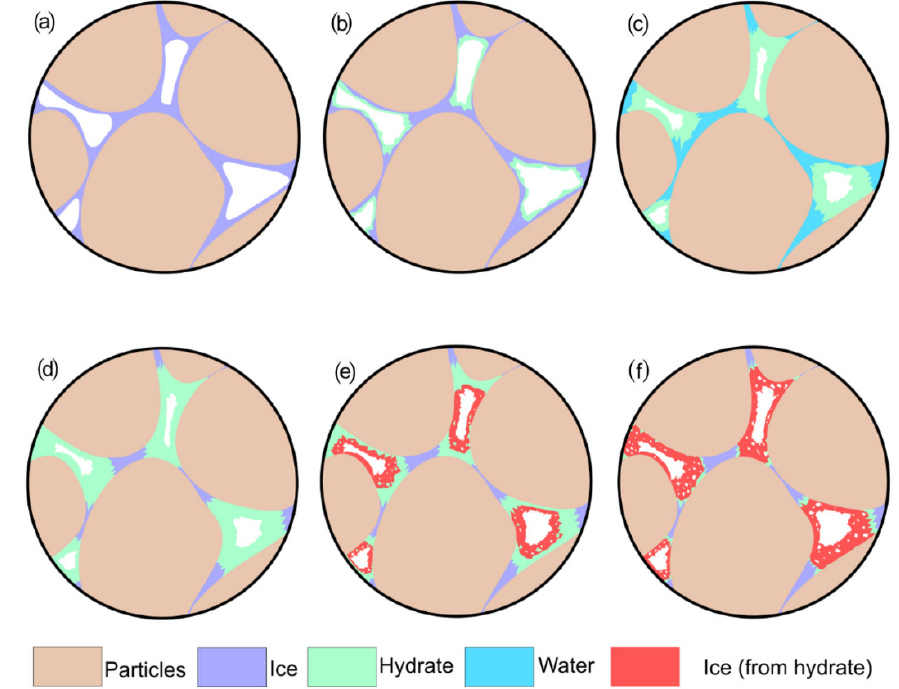
Figure 9. Pore space changes in gas-saturated sediments exposed to hydrate formation at t < 0 °C, thawing and freezing, and hydrate dissociation at t < 0 °C. Stages: ( a ) initial (before hydrate formation), ( b ) hydrate formation at t < 0 °C, ( c ) thawing, ( d ) freezing, ( e ) self-preservation of pore hydrate at p = 0.1 MPa, ( f ) hydrate dissociation at N2 atmosphere, p = 3 MPa.